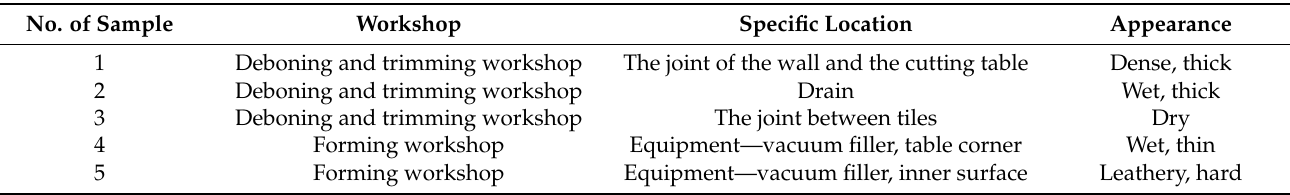
Table 1. Biofilms sampled for research at meat processing